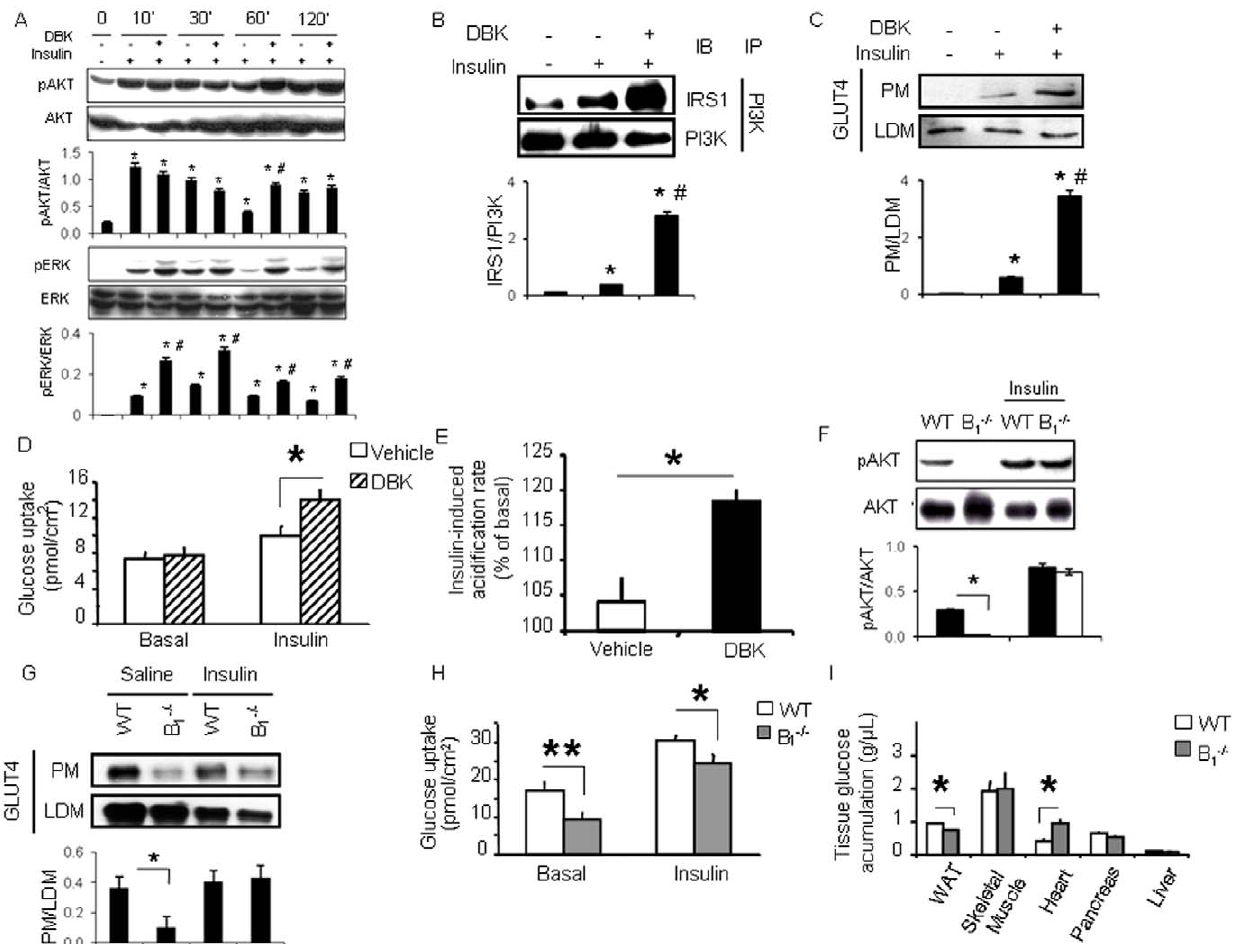
Figure 2. Kinin B 1 R modulates insulin action in mouse adipocytes. A: AKT and ERK phosphorylation upon stimulation of differentiating 3T3- L1 preadipocytes with 10 m g/mL insulin (in the presence of 1 m M dexamethasone, 0.5 mM 3-isobutyl-1-methylxanthine and 10% FBS). *, P , 0.05; vs. non-stimulated; # , P , 0.05: vs. insulin only. The blots and quantification are one representative experiment out of three performed independently. B: 3T3-L1 adipocytes were incubated with or without 1 m M DBK for 90 minutes prior to 10 min stimulation with 1 m g/mL insulin. Cells were harvested for immunoprecipitation (IP) followed by immunoblotting (IB) or C: membrane fractionation for assessment of GLUT4 translocation by western blotting. *, P , 0.05; vs. non-stimulated; # , P , 0.05: vs. insulin only. The blots and quantification are one representative experiment out of two performed independently. D: Isolated epididymal adipocytes of WT mice were incubated with 5 mM glucose media with or without 1 m M DBK for 90 minutes and [ 3 H]-2-deoxy-glucose accumulation was measured under basal conditions or after 15 min stimulation with 10 nM insulin. Data represent mean 6 SEM of at least 8 independent samples obtained from an adipocyte pool of 15 animals. *, P , 0.05 vs. respective control. E: Effect of 90 minutes incubation with 1 m M DBK on the insulin-induced extracellular acidification rate of 3T3-L1 adipocytes measured by Cytosensor system (*, P , 0.05; n =4 per group). Data represent mean 6 SEM of extracellular acidification. F: Random fed WT or B 1 2 / 2 mice ( n =4 per group) were injected in the vena cava with either saline or a 10 U insulin bolus. Epididymal fat was harvested after 10 minutes for assessment of AKT phosphorylation by western blotting or G: GLUT4 translocation. H: Glucose uptake was assessed in isolated epididymal adipocytes of WT and B 1 2 / 2 cells under basal conditions or after 15 min stimulation with 10 nM insulin. Data represent mean 6 SEM of at least 8 independent samples obtained from an adipocyte pool of 15 animals. *, P , 0.05; **, P , 0.001 vs. respective control. I: Fasted mice received 0.2 U human insulin per kg, 0.083 mCi [ 3 H]-2-deoxy-glucose per kg was subcutaneously injected, mice were sacrificed and tissue collected. Data show mean 6 SEM of 5 animals per genotype. *, P ,